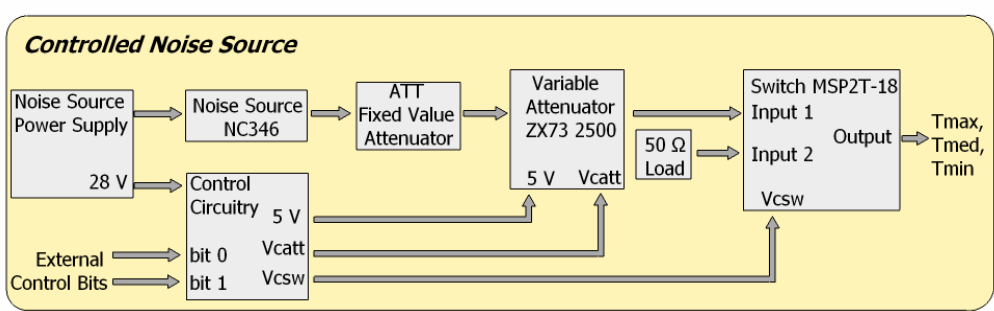
Figure 10. Controlled Noise Source (CNS) block diagram. The core of this sub-system is the noise source Noise Com NC346.